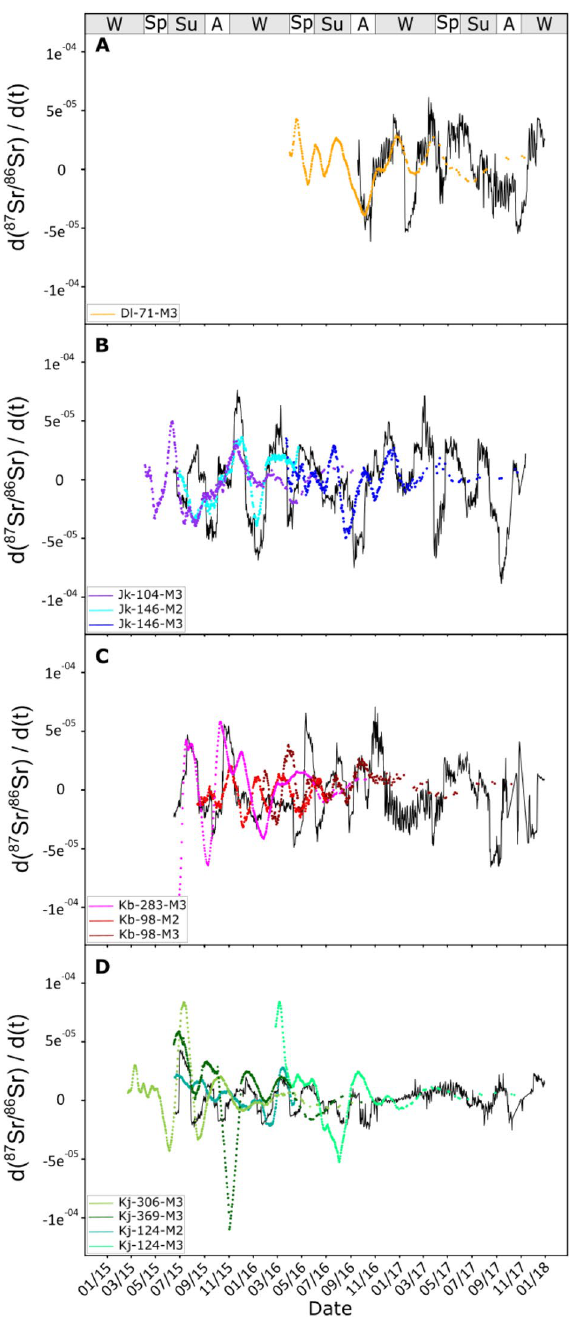
Figure 3. Comparison between the variation of the derivative of the modeling of intra-tooth variations. Variation predicted by the forward model (black line) and the derivative of measured intra-tooth variations of 87 Sr/ 86 Sr running mean (colored full line) for animals belonging to ( A ) Dl, ( B ) Jk, ( C ) Kb, and ( D ) Kj. The time calibration of measured intra-tooth profiles was done using the time lag given by cross-correlation. The date is given as month and year. (W = winter; Sp = spring; Su = summer; A =